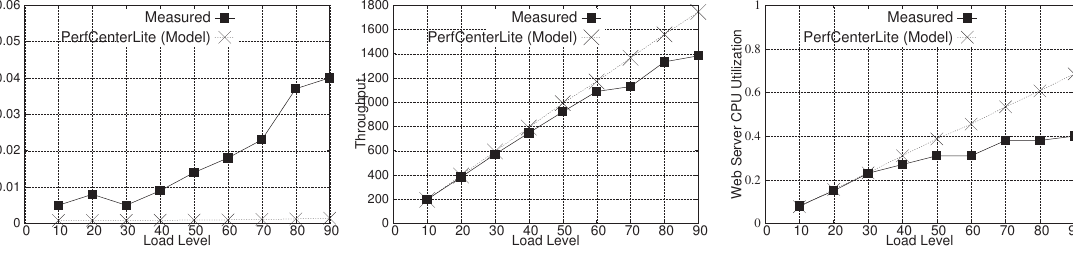
Figure 5: Measured vs Modeled Performance Metrics Validation for different processor architecture (Experiment 3)